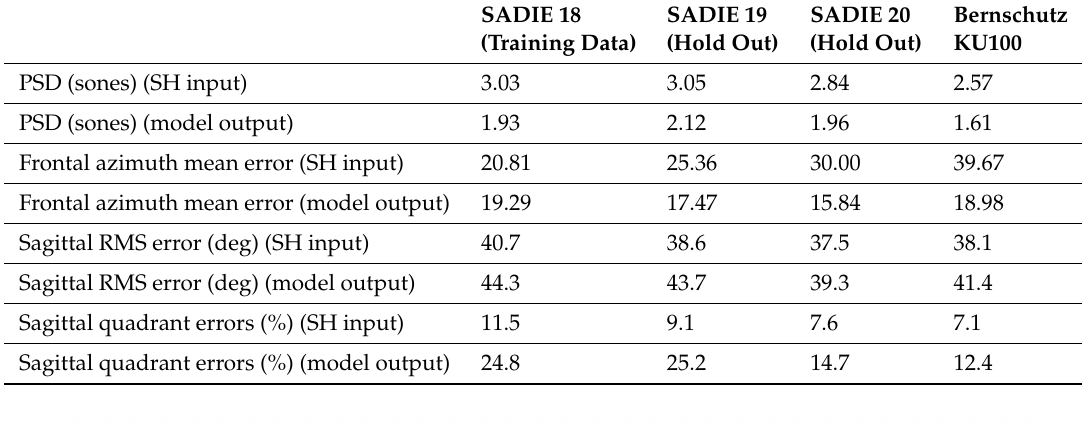
Table 8. Predicted model performance with various head related transfer function (HRTF) sets.